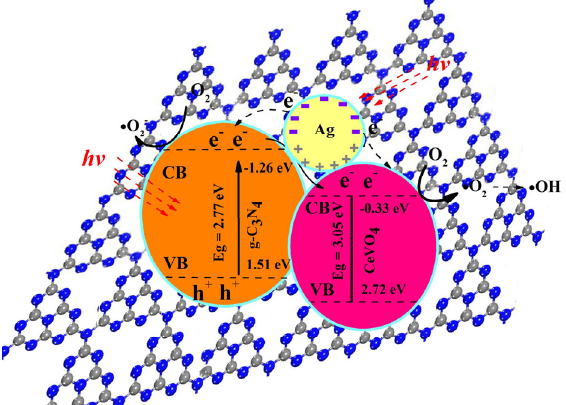
Fig. 7 Schematic diagram of the charge carrier separation and transfer in ternary composites under visible light